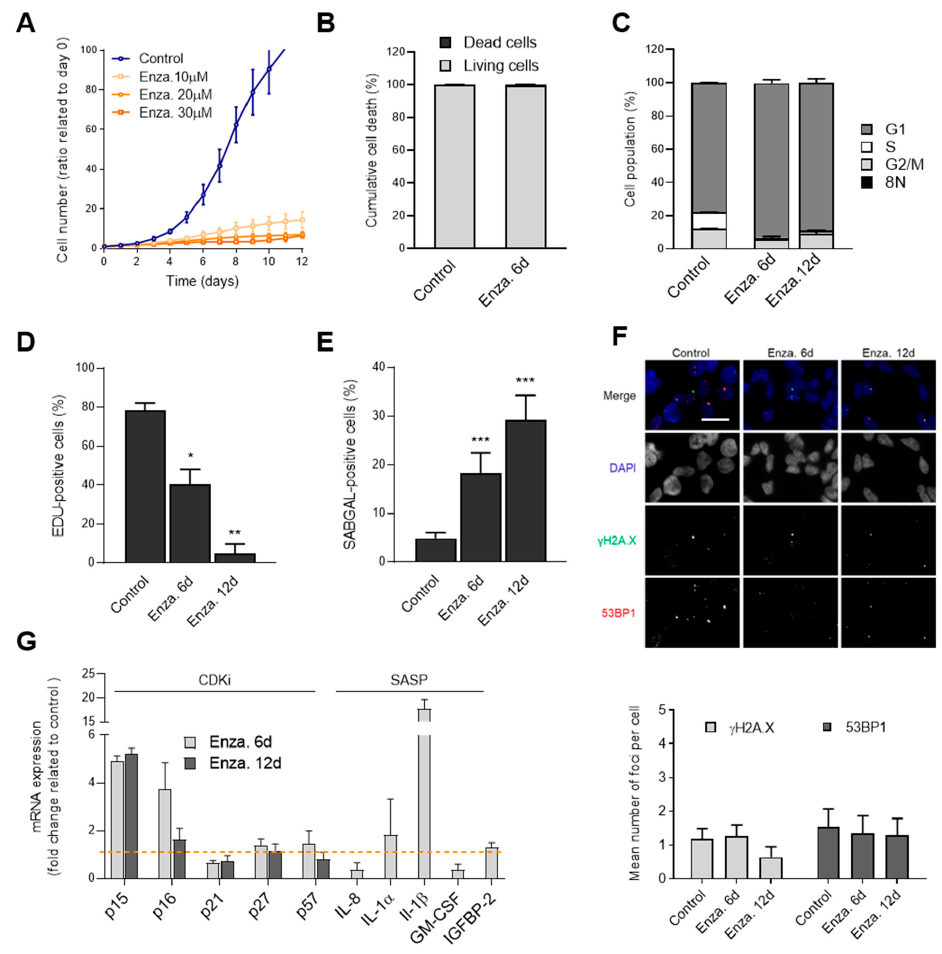
Figure 4. Enzalutamide triggers a senescence-like state in LNCaP cells. ( A ) Cell proliferation curves of LNCaP expressing H2B-GFP and treated with increasing concentrations of enzalutamide (Enza). Data are the mean ± SD of triplicate and are representatives of three independent experiments. ( B ) The cumulative cell death of LNCaP was analyzed by flow cytometry 6 days after 10 µM Enza exposure. ( C ) Flow cytometry analysis of LNCaP cell cycle populations following 6 or 12 days’ exposure to 10 µM Enza. ( D ) Cell proliferation was assessed by incorporation of EdU for 24 h at 5 or 11 days after 10 µM Enza exposure. ( E ) SA- β -gal assay was performed 6 or 12 days after 10 µM Enza exposure. ( F ) Representative images (top) and quantifications (bottom) of γ H2AX (green) and 53BP1 (red) foci per nucleus in LNCaP cells 6 days following 6 or 12 days exposure to 10 µM Enza. The merged red and green channels show colocalization in yellow and DAPI is shown in blue. Scale bar = 20µM ( G ) Relative mRNA levels of CDKi and SASP factors were evaluated by real-time Q-PCR in LNCaP cells exposed to 10 µM Enza for 6 or 12 days. The values represent the fold change expression related to non-treated controls (represented by dashed line). ( B – F ) The mean ± SD of three independent experiments is shown. Statistical analysis: ( B – F ) two-tailed Student’s t -test; ( G ) two-way ANOVA. * p < 0.05, ** p < 0.01, *** p < 0.001.